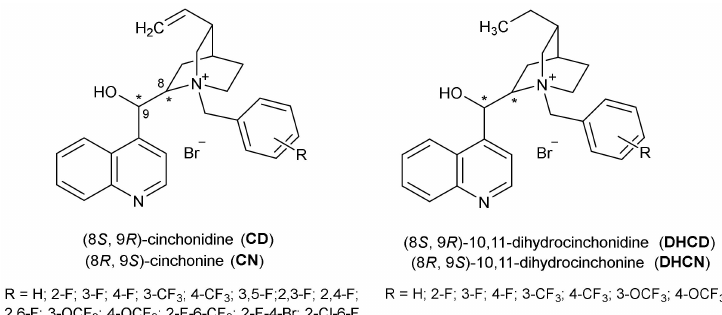
Figure 2. Structures of prepared compounds: CD Bzl (R=H); CD 2F; CD 3F; CD 4F; CD 3CF 3 ; CD